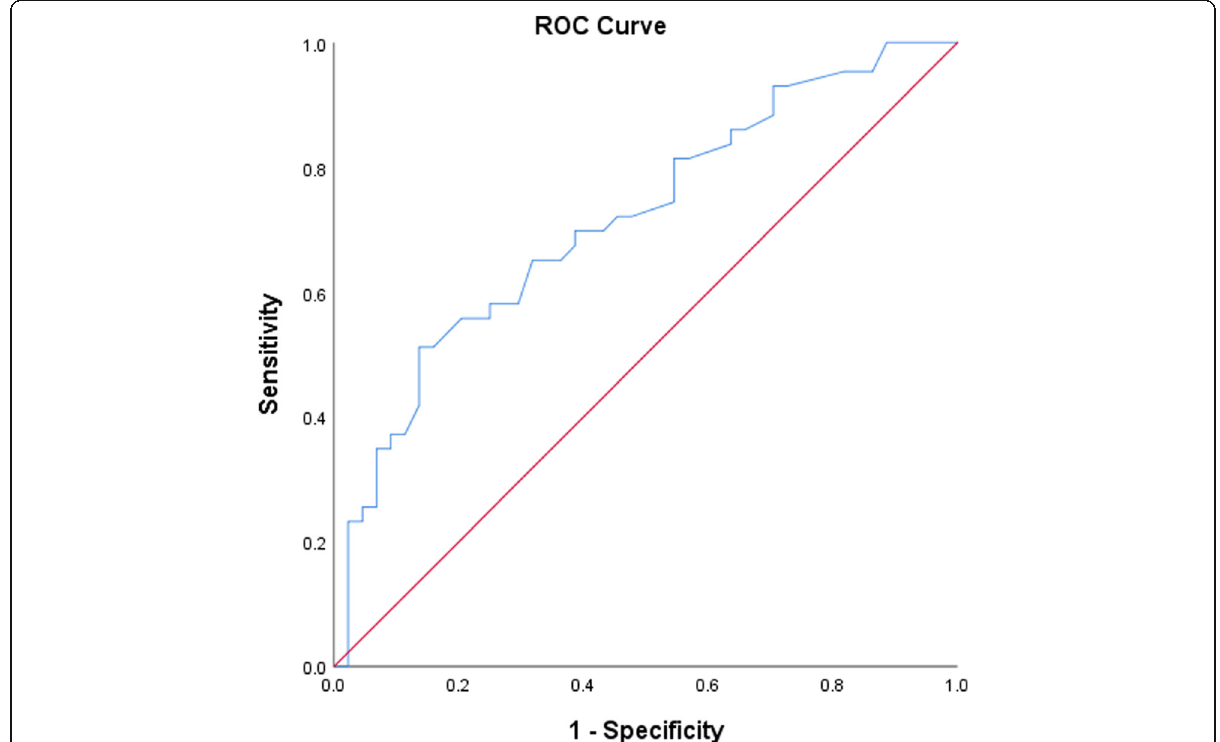
Fig. 2 The ROC curve of the combined predictor of KSS improvement. The new combined predictor combined the time since operation (TSO) with the angle E, and the area under the ROC curve was